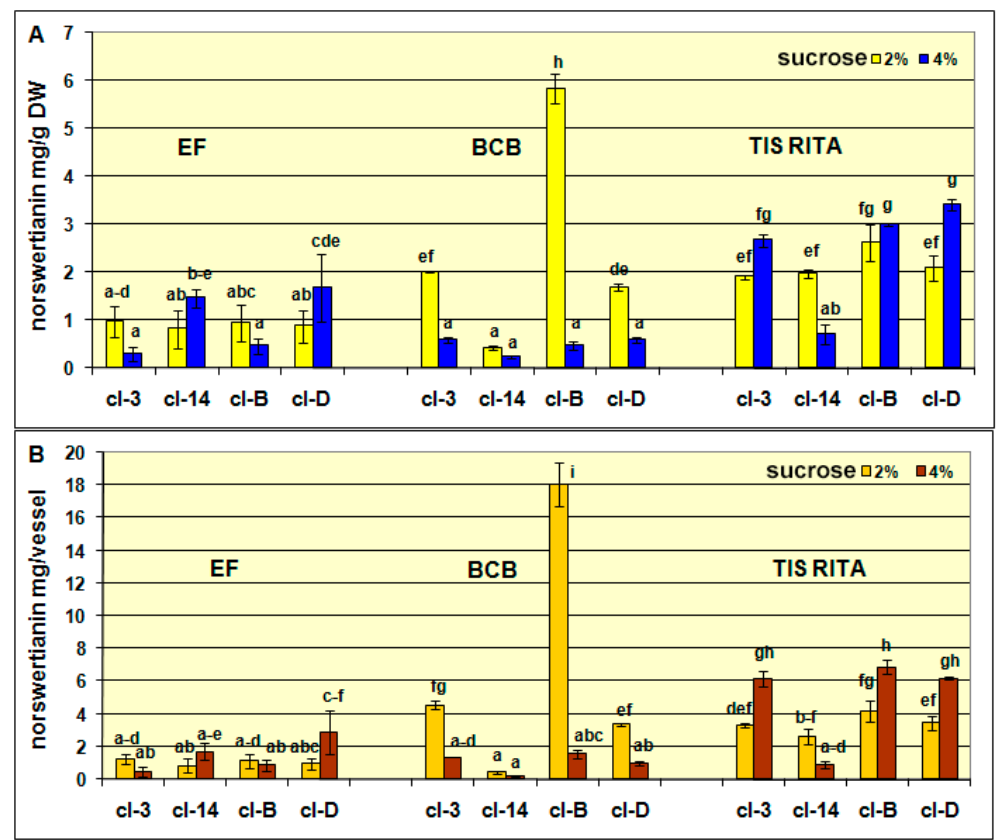
Figure 5. The content of norswertianin in hairy root clones cl-3, cl-14, cl-B, and cl-D, after 7 weeks of cultivation in Erlenmeyer flasks (EF), bubble column bioreactor (BCB) and temporary immersion systems (TIS) RITA ® . ( A ) The contents are presented as mg/g of dry weight and ( B ) the contents are presented as mg per vessel (bioreactor). Values are expressed as mean ± SE ( n = 3–5). The different letters above bars denote significant difference by Fisher’s least significant difference (LSD) test, p ≤ 0.05.